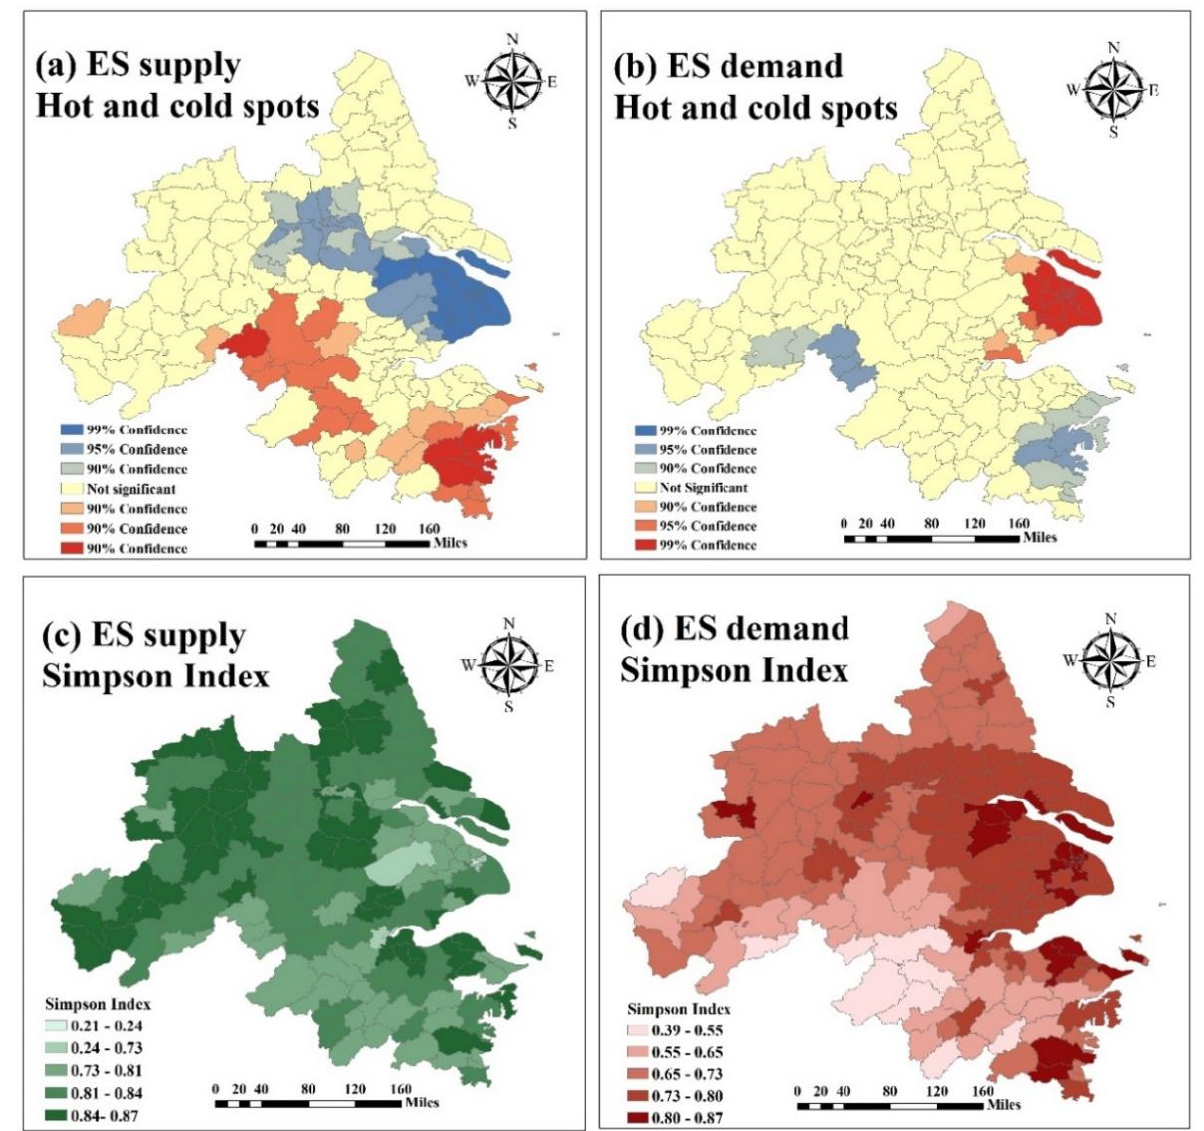
Figure 5. The hot/cold spots ( a , b ) and Simpson index ( c , d ) of ES supply and demand.